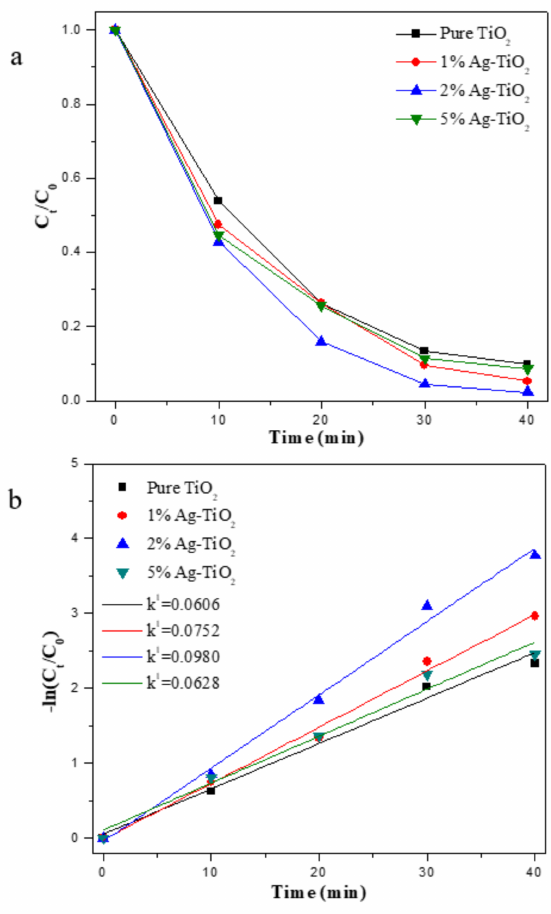
Figure 6. Degradation rate of MO ( a ) and photocatalytic reaction rate ( b ) of TiO 2 and Ag-TiO 2 samples under UV